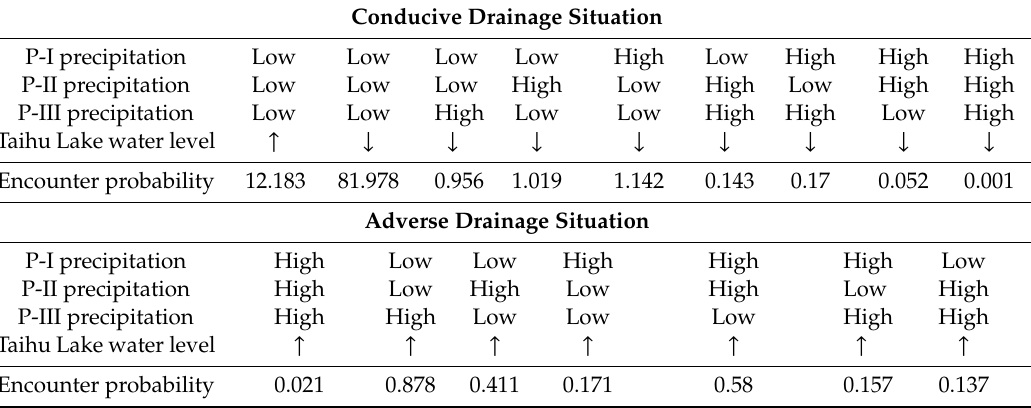
Figure 7. Results of precipitation sub-region division in the plum rain period ( a ) and typhoon period ( b ). Table 7. Calculation of encounter probability during the plum rain period.